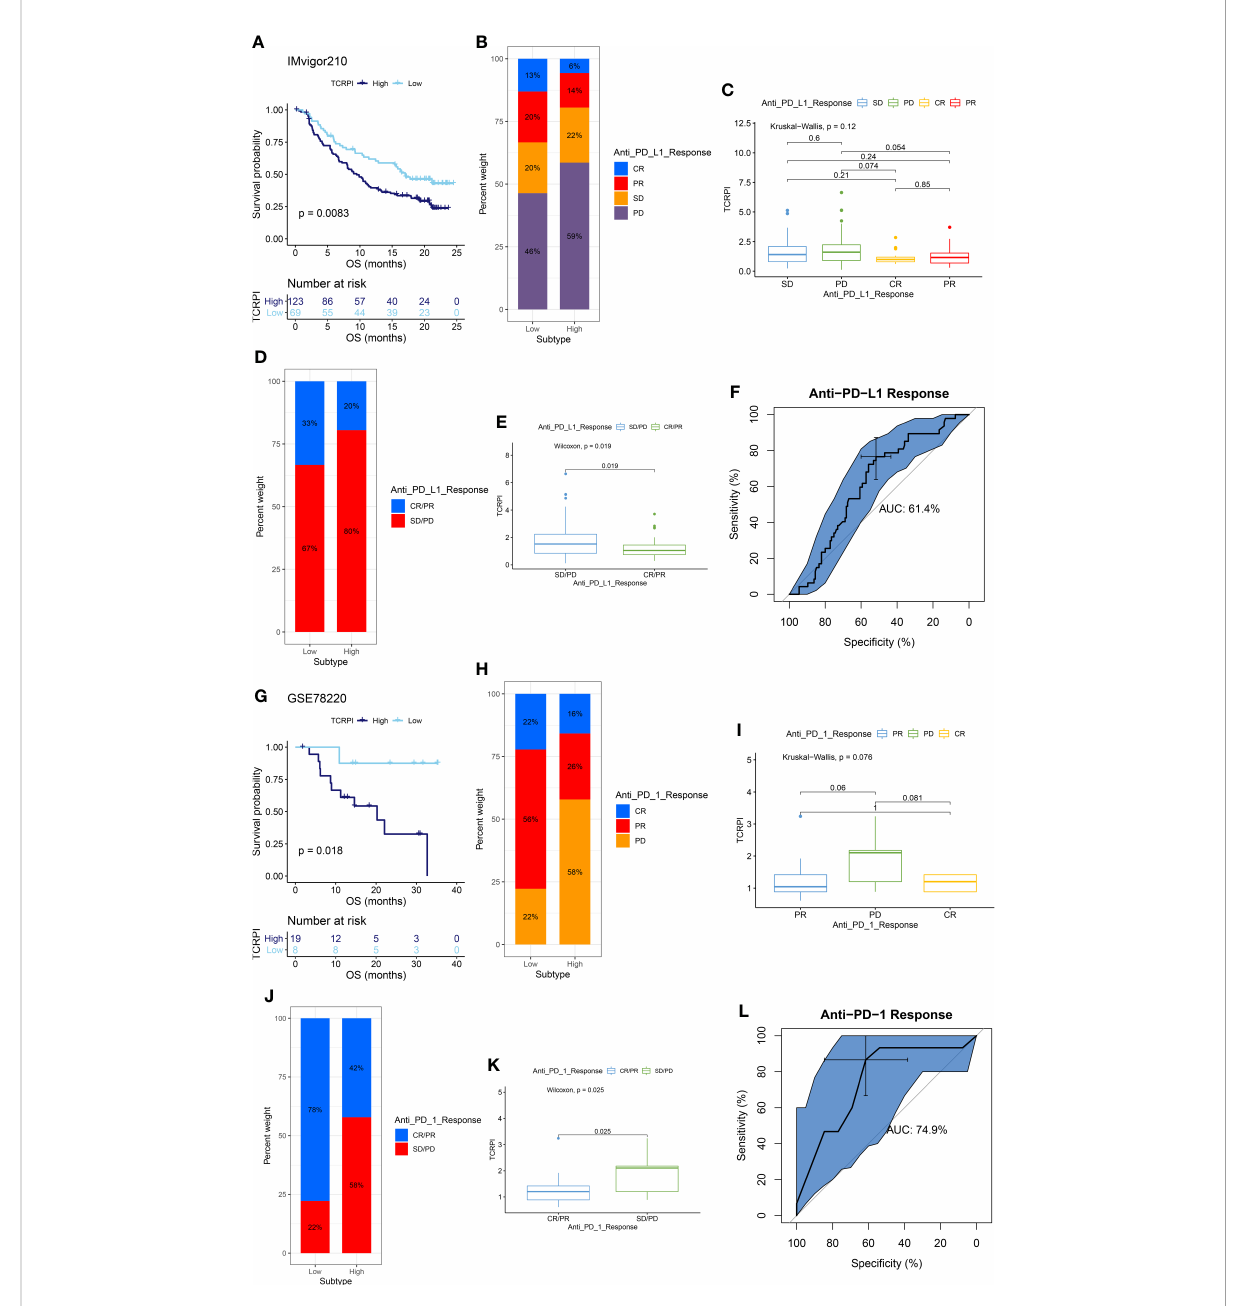
FIGURE 7 TCRPI is a prognostic biomarker and predicts immunotherapeutic bene fi t. (A) Kaplan – Meier curves for patients with high (n = 125) and low (n = 67) TCRPI in the IMvigor210 cohort. (B) Rate of clinical response [complete response (CR)/partial response (PR) and stable disease (SD)/ progressive disease (PD)] to anti-PD-L1 immunotherapy in high or low TCRPI groups in the IMvigor210 cohort. (C) Distribution of TCRPI in groups with different anti-PD-L1 clinical response statuses. (D) Rate of clinical response [complete response (CR), partial response (PR), stable disease (SD) and progressive disease (PD)] to anti-PD-L1 immunotherapy in high or low TCRPI groups in the IMvigor210 cohort. (E) Distribution of TCRPI in groups with different anti-PD-L1 clinical response statuses. (F) ROC curve measuring the predictive value of the TCRPI. (G) Kaplan – Meier curves for patients with high (n = 10) and low (n = 17) TCRPI in the GSE78220 cohort. (H) Rate of clinical response [complete response (CR)/partial response (PR) and stable disease (SD)/progressive disease (PD)] to anti-PD-1 immunotherapy in high or low TCRPI groups in the GSE78220 cohort. (I) Distribution of TCRPI in groups with different anti-PD-1 clinical response statuses. (J) Rate of clinical response (complete response (CR), partial response (PR), stable disease (SD) and progressive disease (PD)) to anti-PD-1 immunotherapy in high or low TCRPI groups in the GSE78220 cohort. (K) Distribution of TCRPI in groups with different anti-PD-1 clinical response statuses. (L) ROC curve measuring the predictive value of the